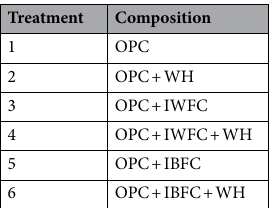
Table 1. Compositions of cementitious composites in each